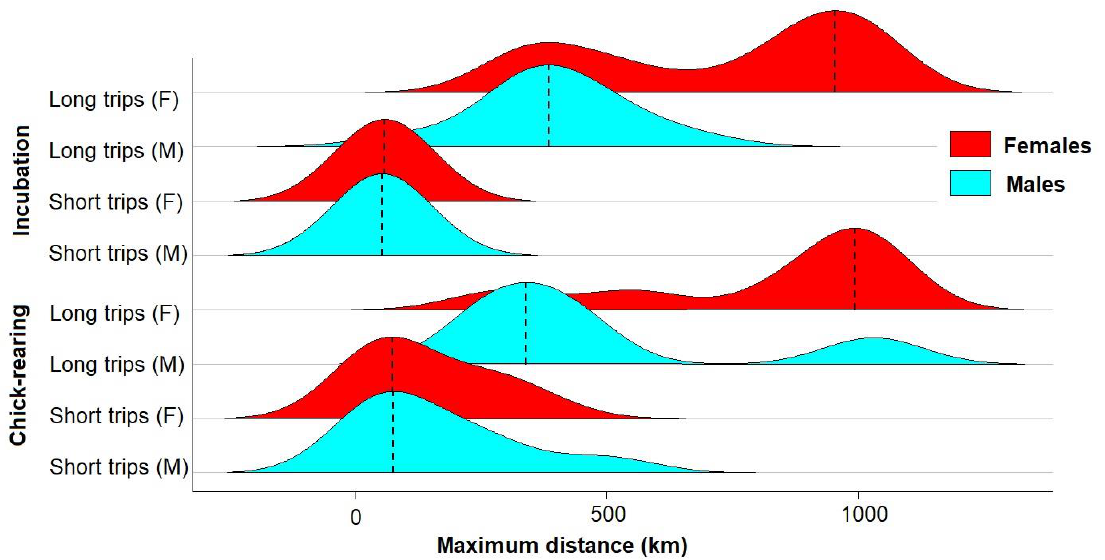
Figure 5. Ridgeline plot of sex differences in maximum distances of Thin-billed Prions from New Island, separately for the breeding phases and trip lengths (short = 1 – 4 days, long = 5 – 11 days). Dashed lines mark the mode.